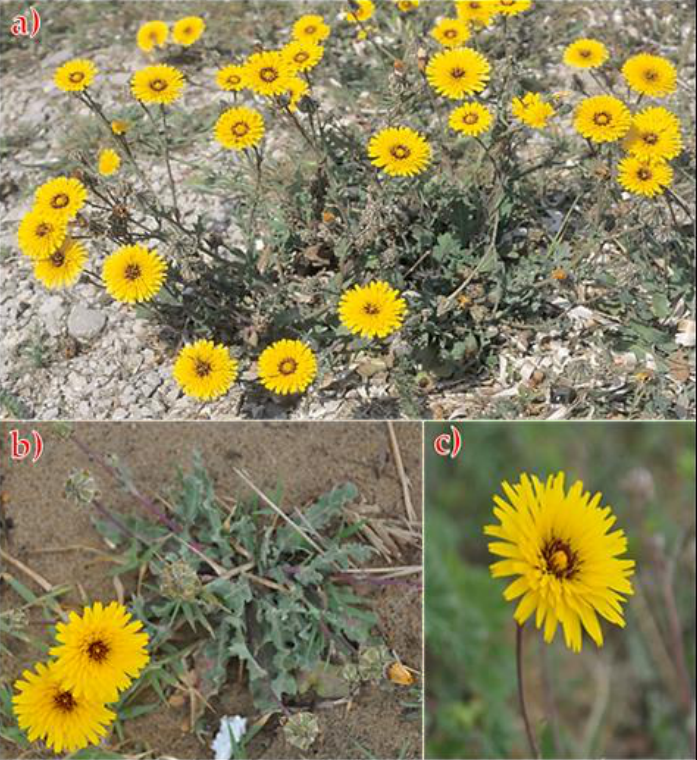
Figure 5. Reichardia tingitana (L.) Roth plant. ( a ) Overview of the growing herb, ( b , c ) close view of vegetative stage and flowering branch.